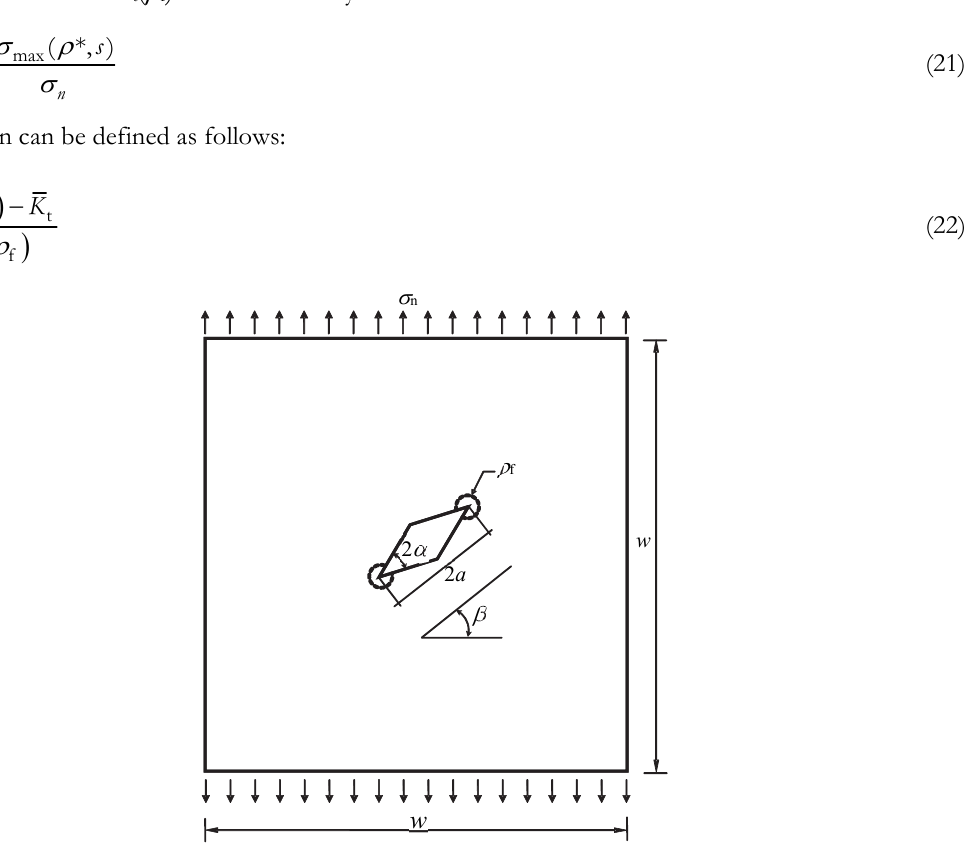
Figure 3: Geometry and dimensions of the double-V-notched quadratic plate specimen considered in the FE analyses; remote loading by prescribed nominal stress  n ; dimensions w = 100 mm and 2 a = 14.14 mm; real pointed versus fictitiously rounded (root hole) V- notch